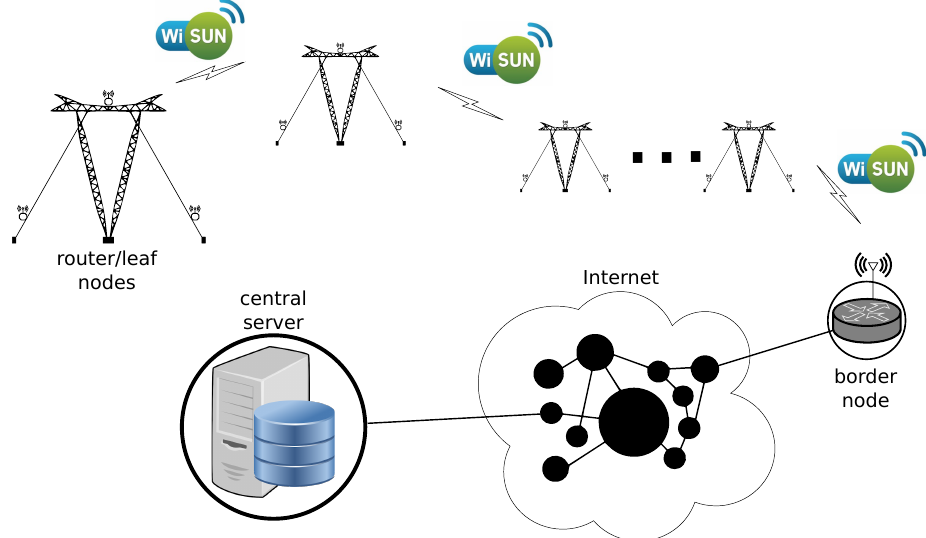
Figure 2. The proposed solution